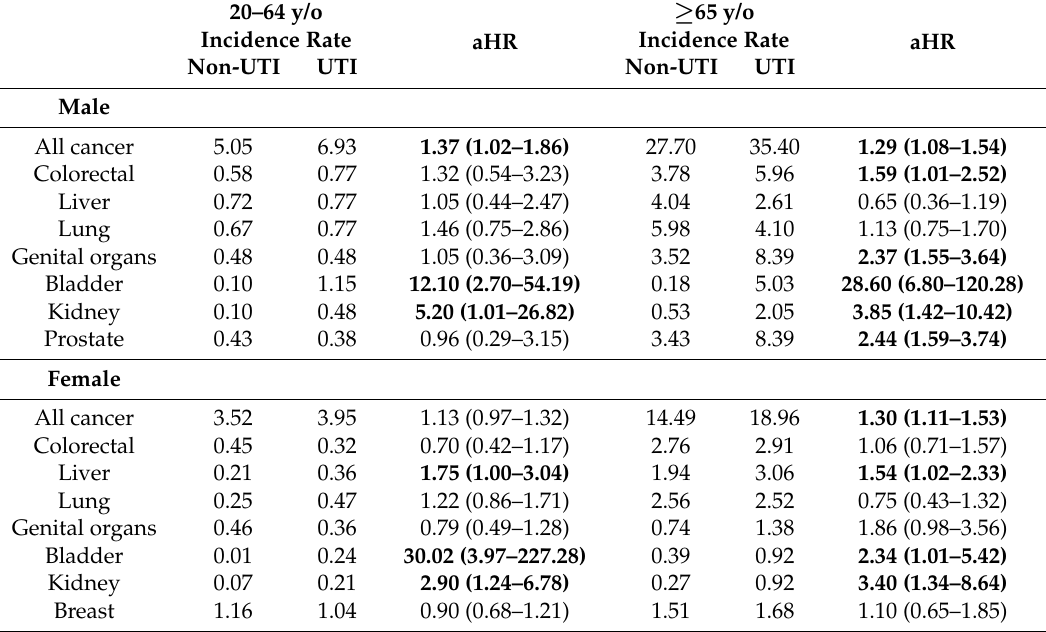
Table 2. Age stratified cancer incidence rate (per 10,000 person months) and adjusted hazard ratio (95% C.I.) † in patients with UTI exposure by cancer site.